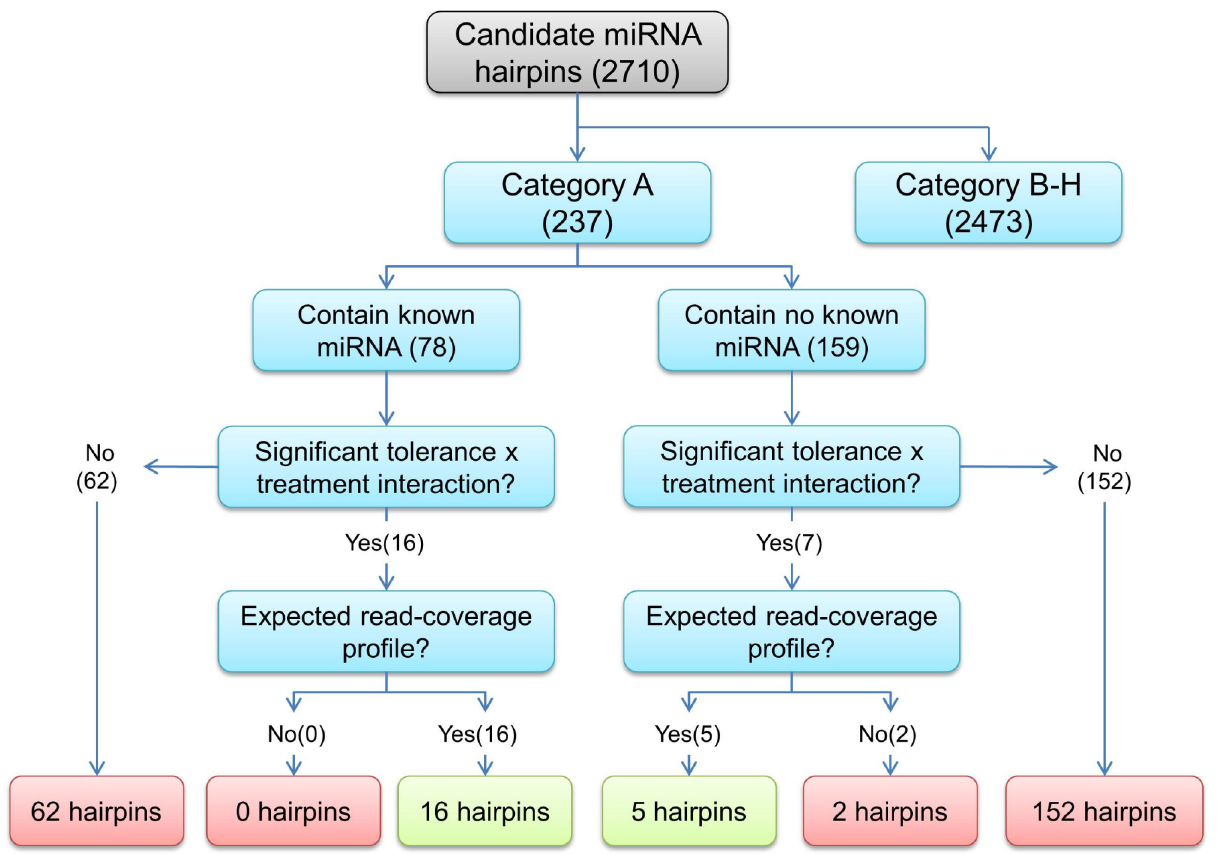
Fig 5. A schematic representation displaying the breakdown of water deficit stress responsive miRNA hairpins identified. A total of 16 hairpins have a significant tolerance × treatment interaction term and contain at least one perfect alignment to a known mature miRNA, while five hairpins have a significant tolerance × treatment interaction term but do not contain a perfect alignment to any known mature